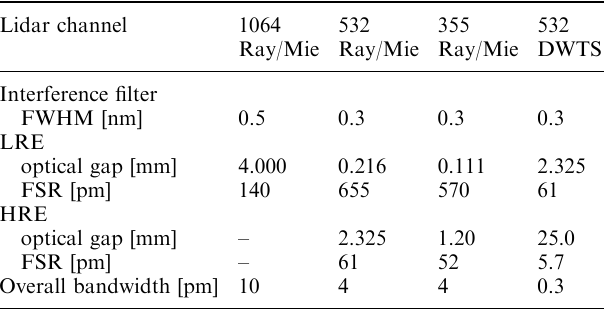
Table 3. Summary of the solar filter parameters ( LRE , low- resolution etalon, HRE , high resolution etalon) Lidar